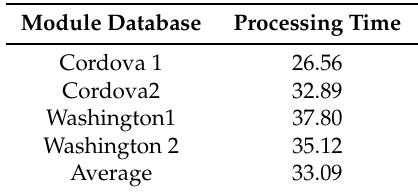
Table 4. Processing time per each frame (unit: ms).